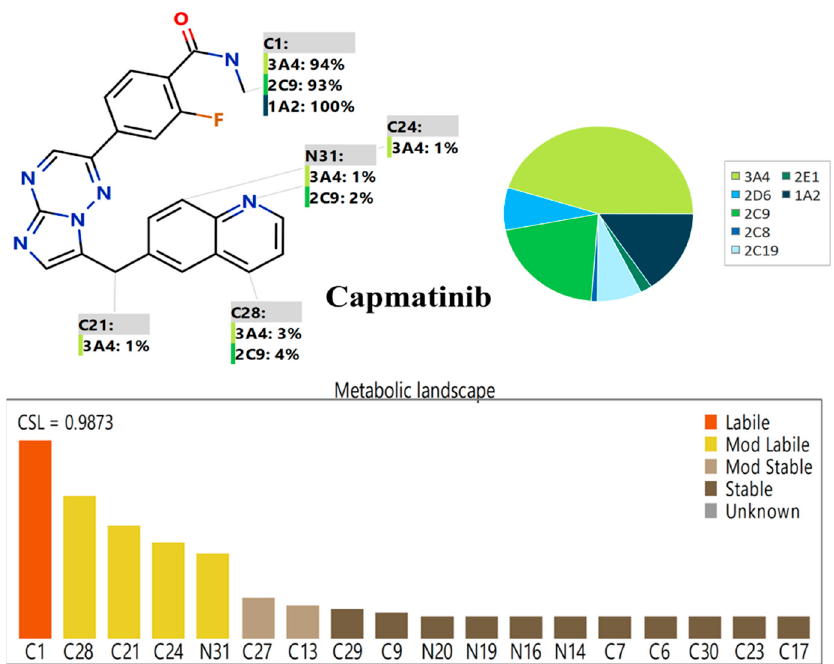
Figure 2. CSL (0.9873) representing the metabolic lability of capmatinib. The results were analysed using the P450 model of the in silico StarDrop software. Table 3. Summary of different experiments aimed at standardizing the chromatographic separation of CMB and PMT